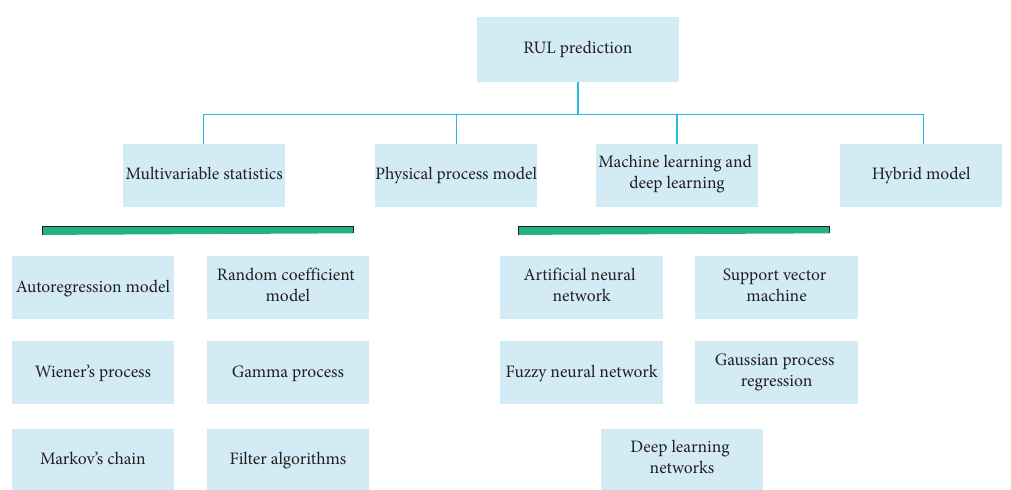
Figure 2: Classification of RUL prediction